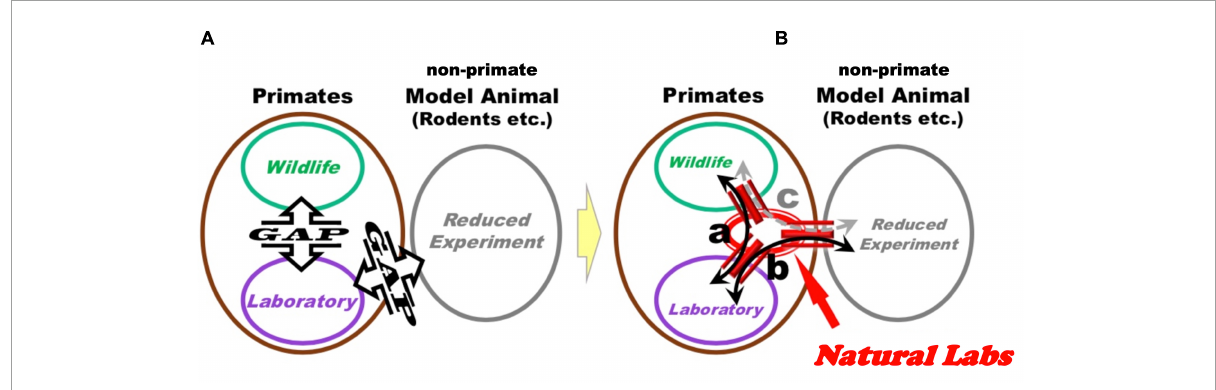
FIGURE2 Through the implementation of the Natural Laboratory Complex by the present proposal, it may be possible to increment exchanges between different research fields. (A) Schematic representation of current research situation, depicting three sub-fields of primate research: wildlife studies, laboratory experimentations (on the left), and non-primate animal model reduced experimentations, rodents or otherwise (on the right). Communication and exchange between these three components are not systematic and left to personal exchanges among individual researchers. (B) “ Natural Laboratories Complexes ” can provide bridges between existing experimental sub-fields. Specifically, investigation of behavior, biological samples and brain activity in Natural Labs can be instrumental to (a) design classical laboratory experiments under controlled conditions, which can inform additional experimental designs in Natural Labs ; (b,c) investigate analogous mechanisms in primate and non-primate animal models to identify potential conserved functions, and use results of these experiments to inform analysis and models related to findings obtained in Natural Labs